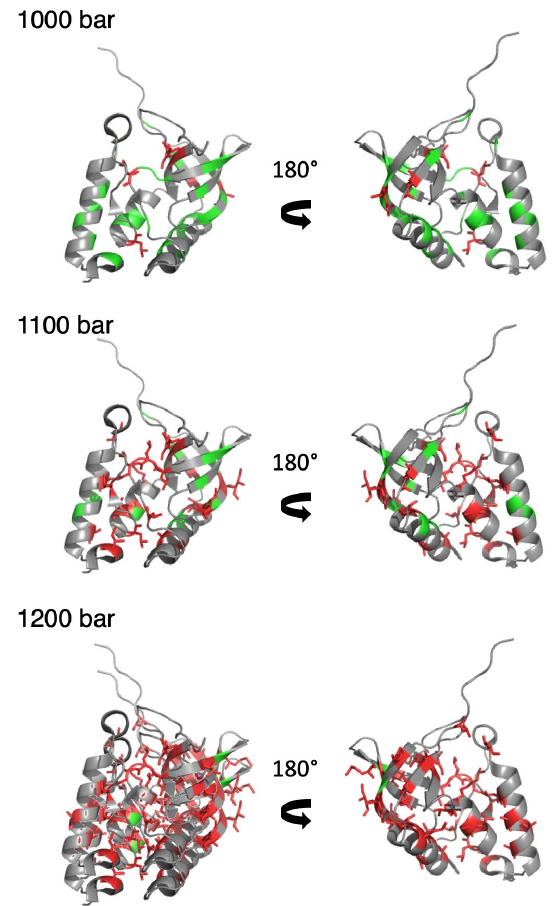
Figure 6. Pressure denaturation of ∆ +PHS SNase probed by side chain CH 3 groups. Two views related by a 180 ◦ rotation along the vertical axis of a ribbon representation of the 3D structure of ∆ +PHS SNase (PDB ID: 3LX0). The green and red color correspond to methylated residues, with fractional probabilities greater or lower than 0.5, respectively. In addition, the side chains of the methylated residues displaying fractional probabilities lower than 0.5 are represented by red sticks. Results obtained at three different pressures (1000, 1100, and 1200 bar) are displayed from top to bottom, as indicated.